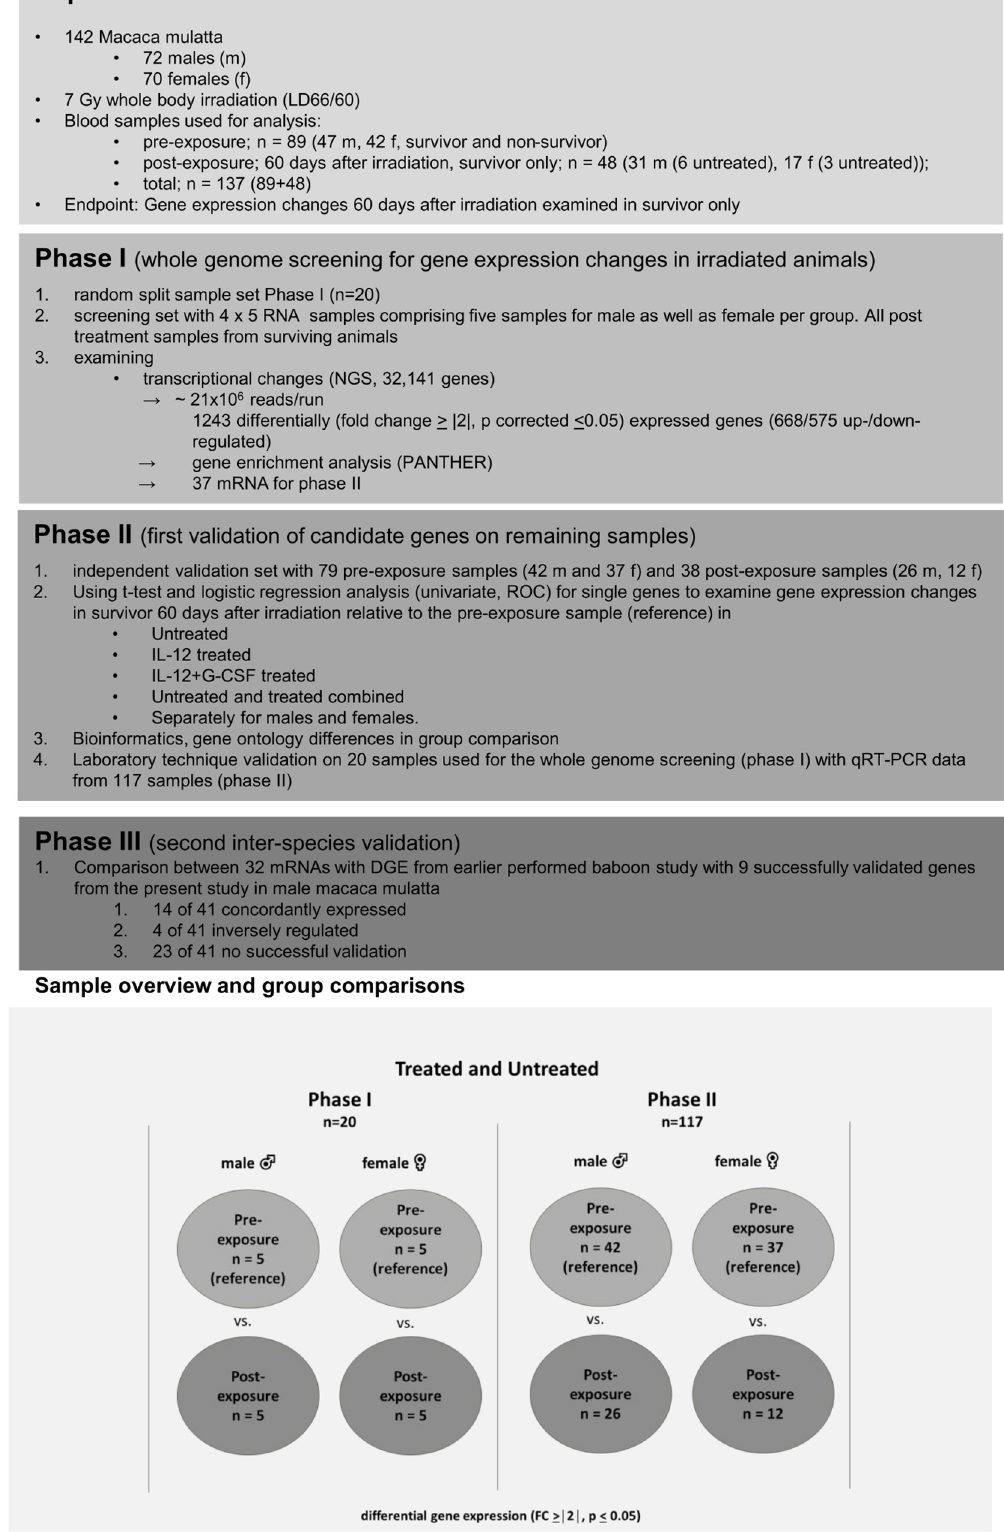
Fig 1. Flow diagram of included samples, three-phase study design, gene expression results, bioinformatics and inter- species validation between rhesus macaques and baboons. The overview shows the samples used in untreated (phase I) as